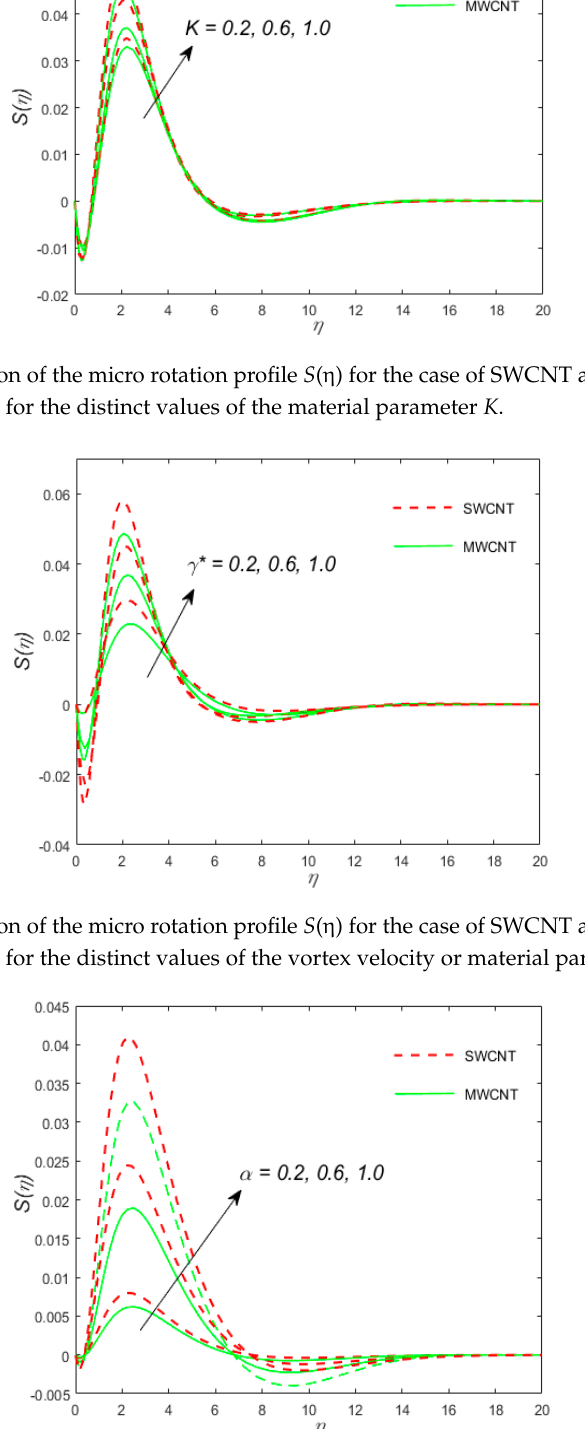
Figure 14. The variation of the micro rotation profile S ( η ) for the case of SWCNT and MWCNT versus the similarity variable for the distinct values of the temperature difference parameter α .